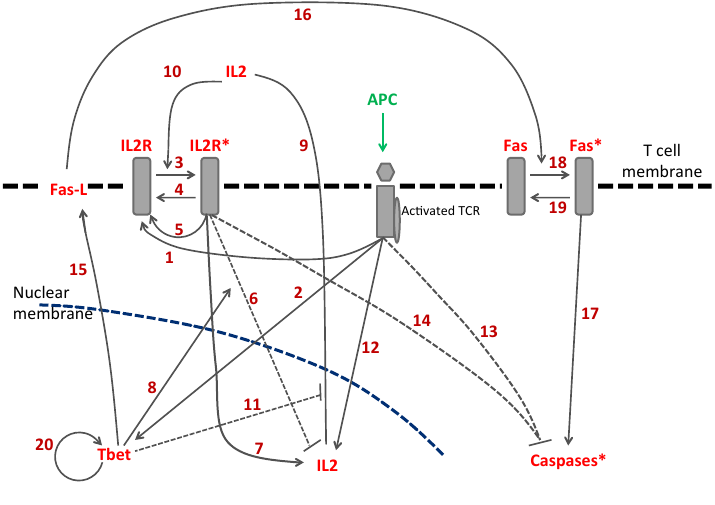
Figure 2. Simplified molecular signaling pathway of a CD8 T-cell. The molecular network gets activated by T-cell receptor (TCR) signaling once a T-cell encounters an antigen presenting cell (APC). The activated IL2 receptor (IL2R ∗ ) plays an essential role in the differentiation of a naïve T-cell into its activated stage, and Tbet into its effector stage. All numbers refer to Table 1. Solid curves, positive feedback; dashed curves, negative